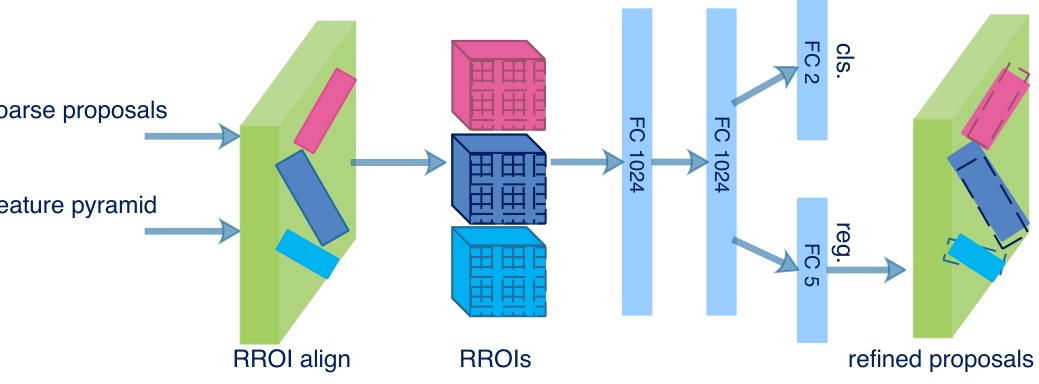
Figure 8. Structure of